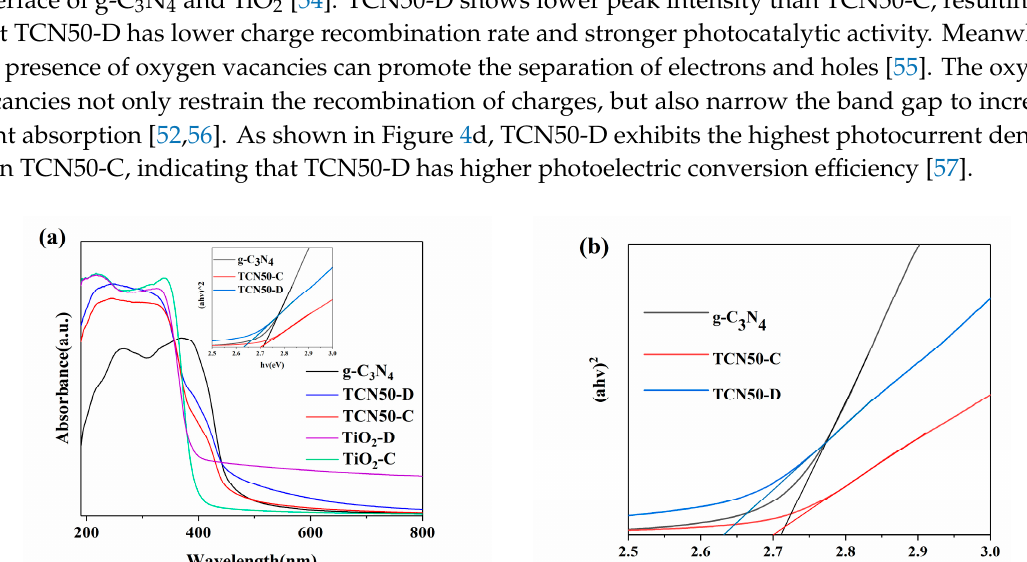
Figure 3. ( a ) EPR spectra of TCN50-C and TCN50-D samples, ( b ) images of TiO 2 prepared by plasma and calcination.